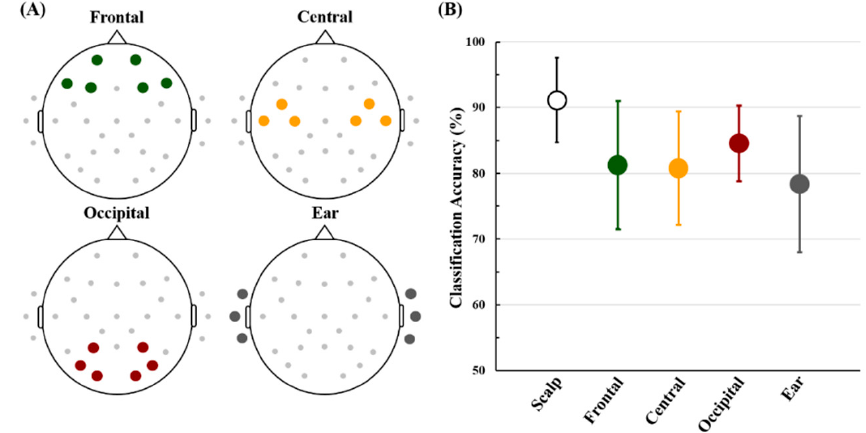
Figure 7. ( A ) Electrode positions used to create each ROI, and ( B ) the mean classification accuracies of the four ROIs with that obtained using all electrodes (‘Scalp’), excluding the six ear electrodes. Each ROI was individually re-referenced, where a CAR was used for the scalp ROIs (‘Scalp’, ‘Frontal’, ‘Central’, and ‘Occipital’) while the mean of three electrodes attached on an opposite ear area was used as a reference signal for ear ROI (‘Ear’). Error bars indicate standard deviations of the estimated classification accuracies of each ROI. There is no significant difference between the four ROIs (Friedman test; p = 0.63).